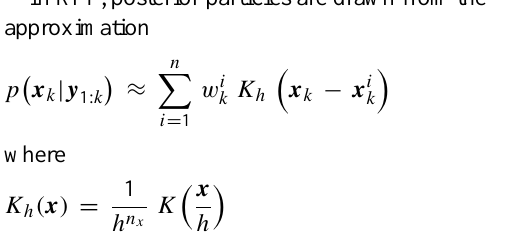
is the rescaled kernel density K( · ) , h > 0 is the bandwidth, and n x is the dimension of the state vector x . The kernel density is a symmetric probability density function